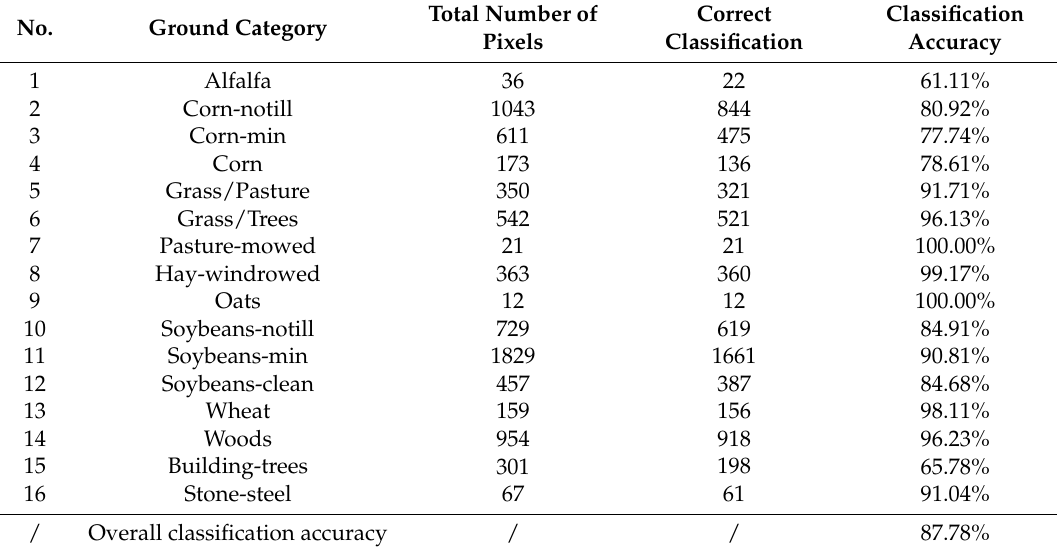
Table 10. Statistical tables for maximum overlap pooling CNN classification charting accuracy used Indian Pines